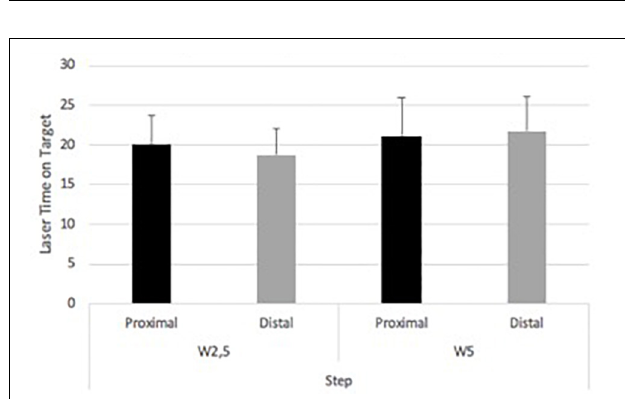
FIGURE 7 | Experiment 2. Laser time on target within foci between wall distances in the step